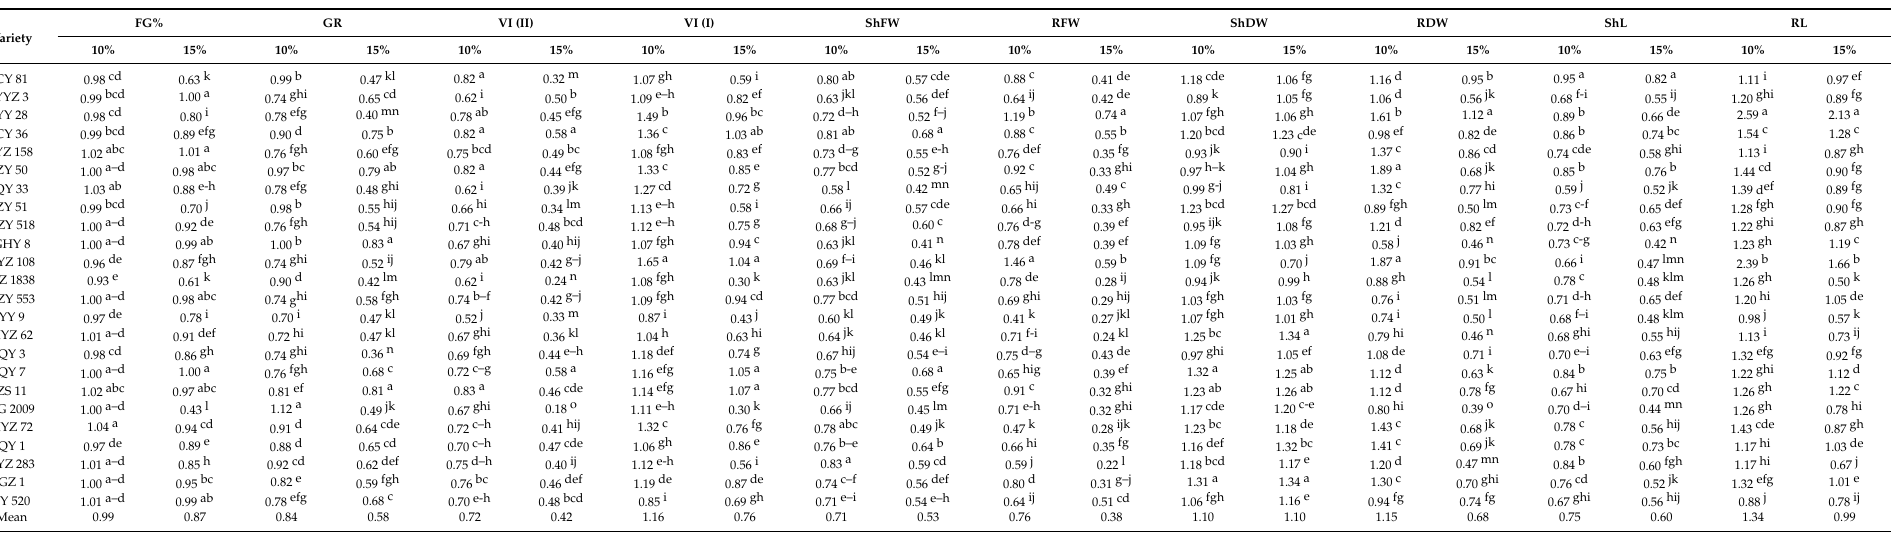
Table 3. Drought tolerance index of germination and seedling growth traits of rapeseed cultivars under drought